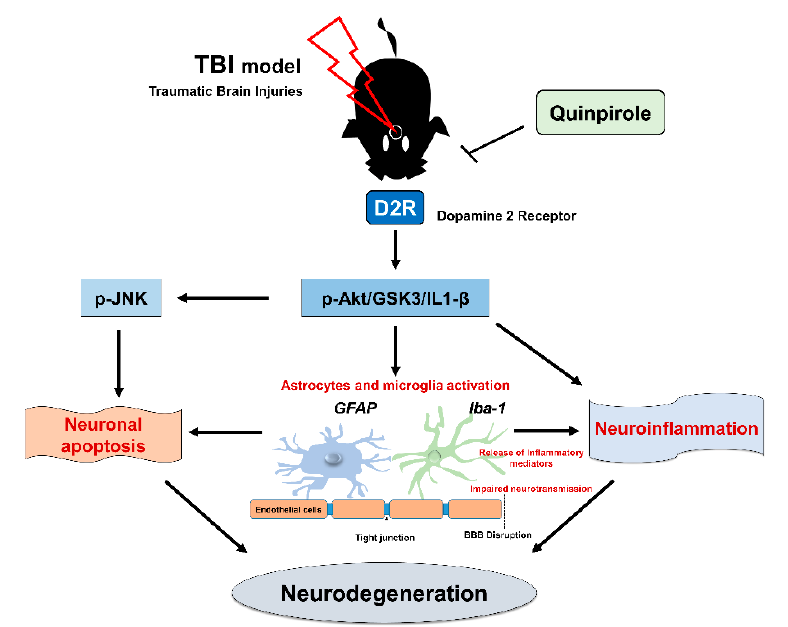
Figure 7. Schematic representation of the proposed mechanism of neuroprotection of quinpirole against brain injury-induced neuroinflammation, BBB disruption and neurodegeneration via D2R and Akt/GSK3- β /IL-1 β signaling in the injured mouse brains.